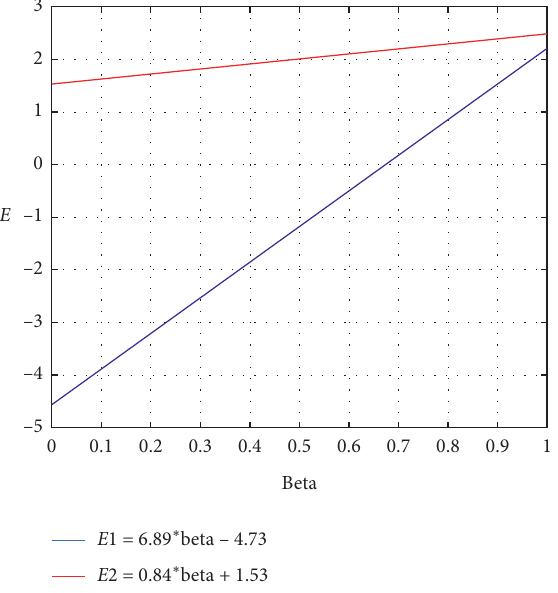
Figure 8: Function graphs of E A